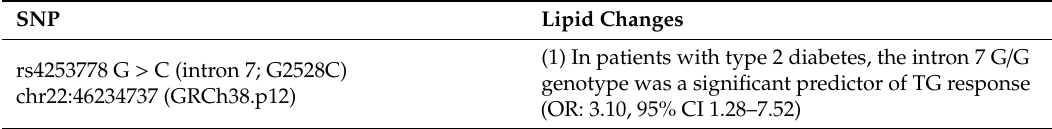
Table 3. PPAR α polymorphisms and di ff erence in fenofibrate